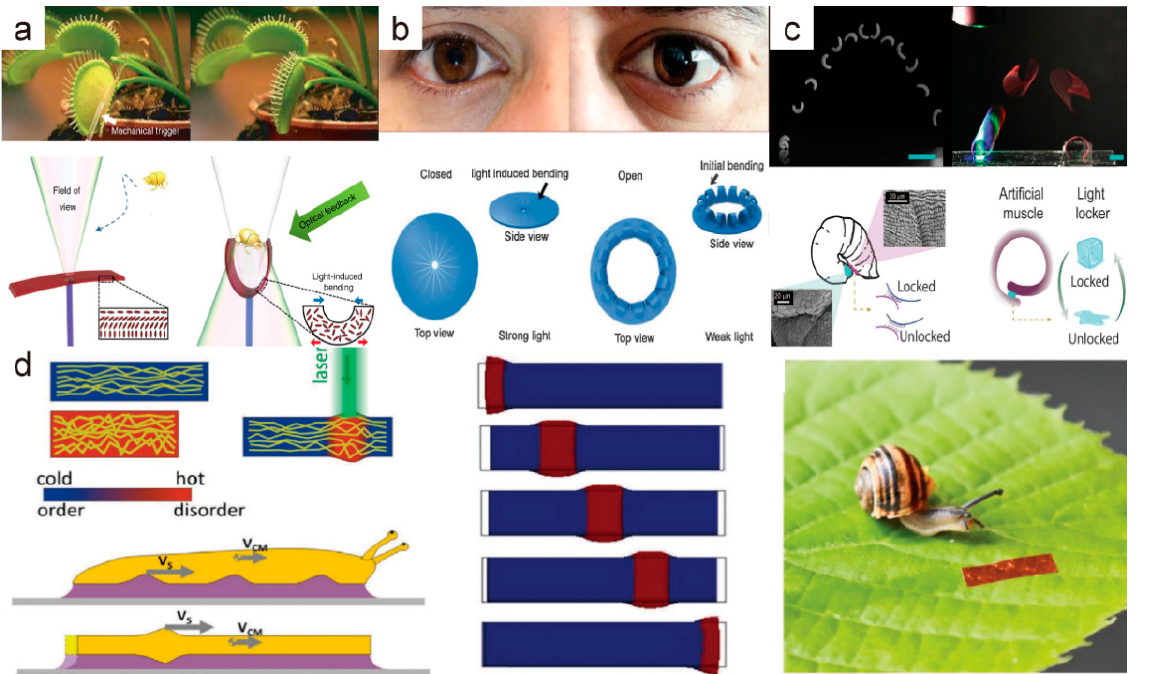
Figure 9. ( a ) Bionic light-powered artificial Venus flytrap robot and its working principle (Reprinted with permission from Ref. [5]. Copyright 2017, Springer Nature). ( b ) Light-driven LCE device simulating human iris structure and its negative feedback mechanism schematic (Reprinted with permission from Ref. [37]. Copyright 2017, John Wiley and Sons). ( c ) A light-controlled robot that can simulate the jumping of gall midge larvae and its energy storage and release mechanism (Reprinted with permission from Ref. [85]. Copyright 2021, John Wiley and Sons). ( d ) A snail-inspired LCE robot and its movement principle (Reprinted with permission from Ref. [84]. Copyright 2019, John Wiley and